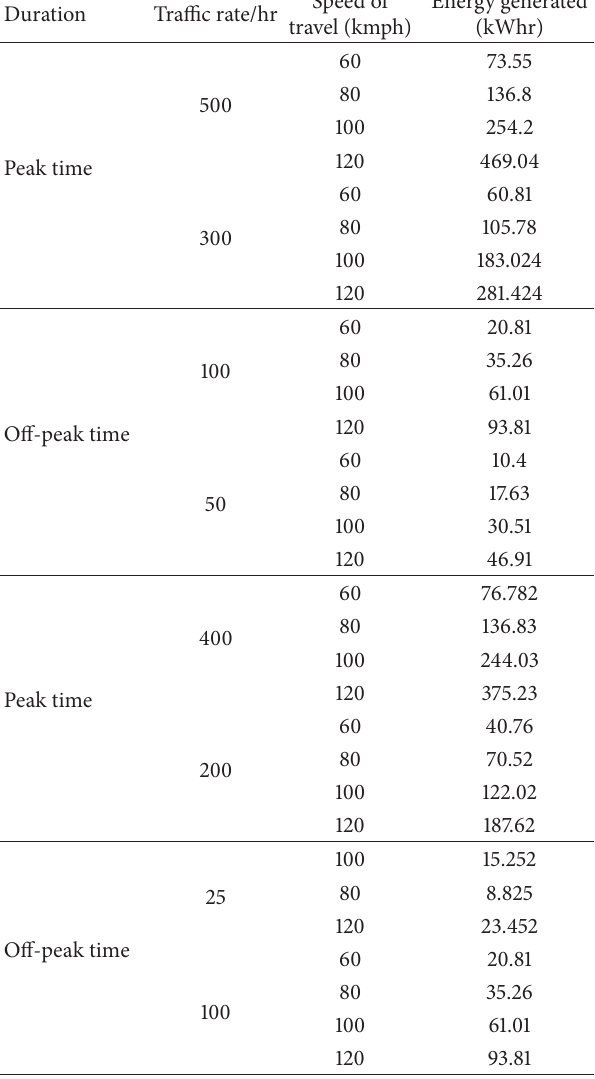
Table 7: Overall power generation from inverter stage.